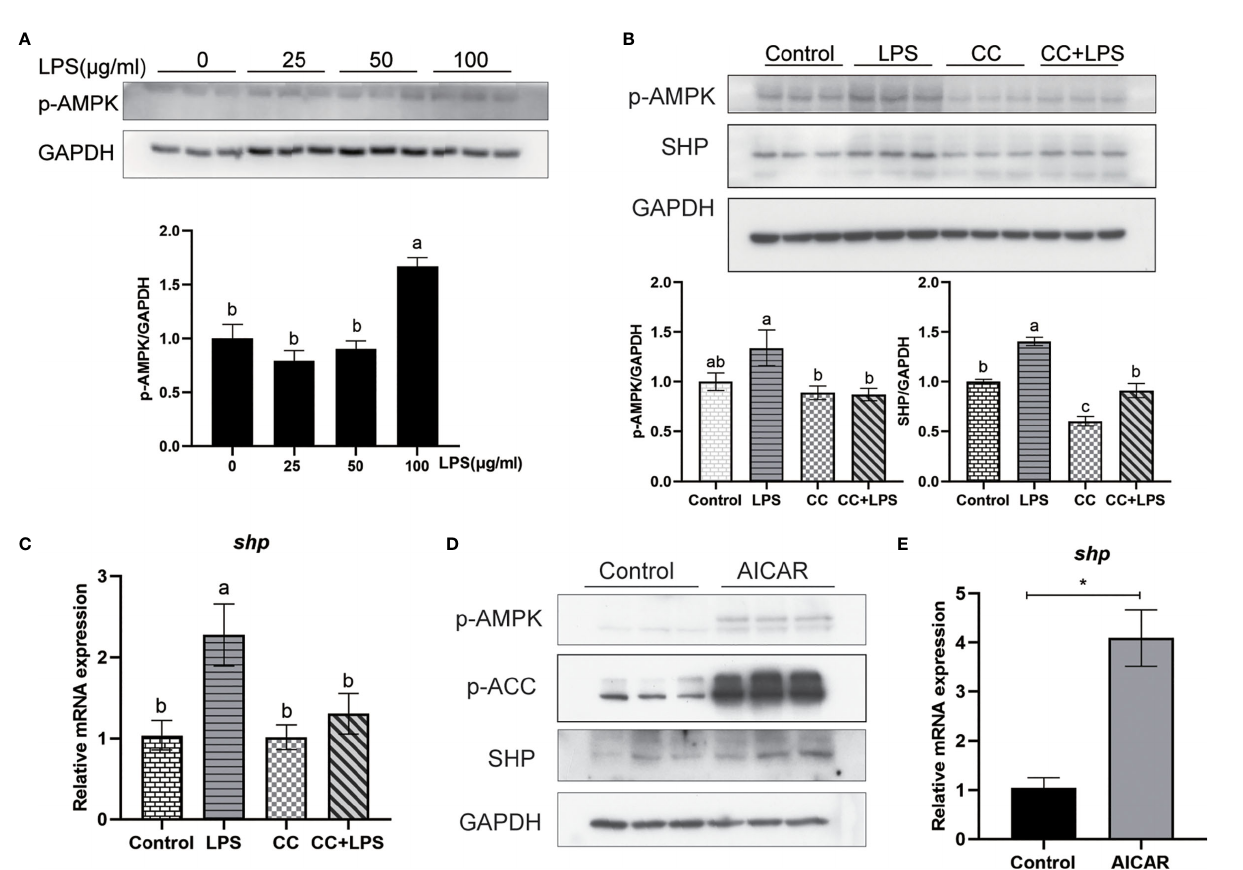
FIGURE 8 | LPS induces the expression of SHP through the AMPK signaling pathway. (A) Immunoblots for phosphorylated AMPK in macrophages after LPS stimulation. (B) Immunoblots for phosphorylated AMPK and SHP in macrophages after LPS stimulation alone or with AMPK inhibitor (CC). (C) Expression of shp in macrophages after LPS stimulation or AMPK inhibitor treatment. (D) Effects of AMPK activator (AICAR) on protein levels of phosphorylated AMPK, phosphorylated ACC and SHP in macrophages. (E) Gene expression of shp in macrophages after treatment with AICAR. Data are presented as means ± SEMs, n = 3 replicate experiments. Signi fi cance was evaluated by one-factor ANOVA followed by Duncan ’ s multiple range test. Labeled means without a common letter differ, P < 0.05. ∗ Different from control, P < 0.05 (Student ’ s t -test). ACC, Acetyl-CoA carboxylase; AMPK, Adenosine 5 ’ -monophosphate (AMP)-activated protein kinase; AICAR, 5-aminoimidazole-4- carboxamide ribonucleotide; CC, Compound C; LPS, lipopolysaccharide; SHP, small heterodimer partner; GAPDH, glyceraldehyde-3-phosphate